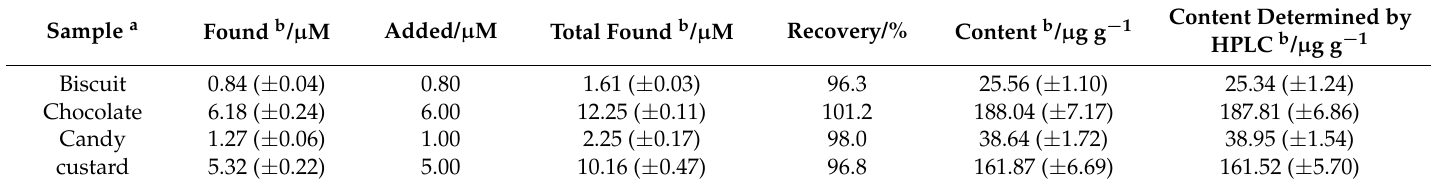
Table 2. Determination of vanillin in food samples ( n = 4). HPLC—high performance liquid